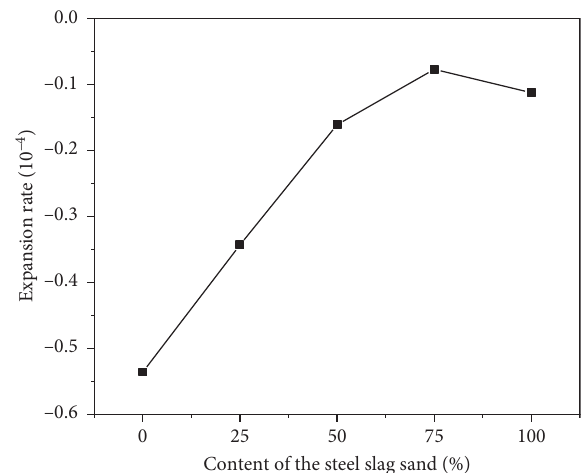
Figure 16: The impact of the content of steel slag sand on the expansion rate of the FSSAC.